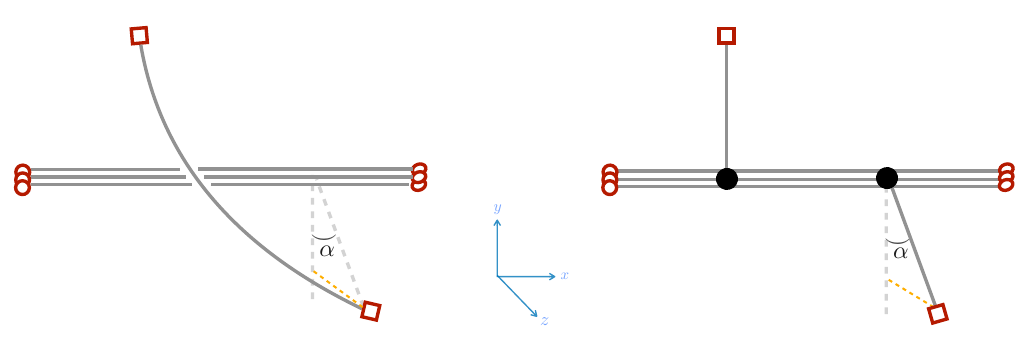
Figure 13 . The two competing brane webs after the supersymmetry breaking deformation, in the large N